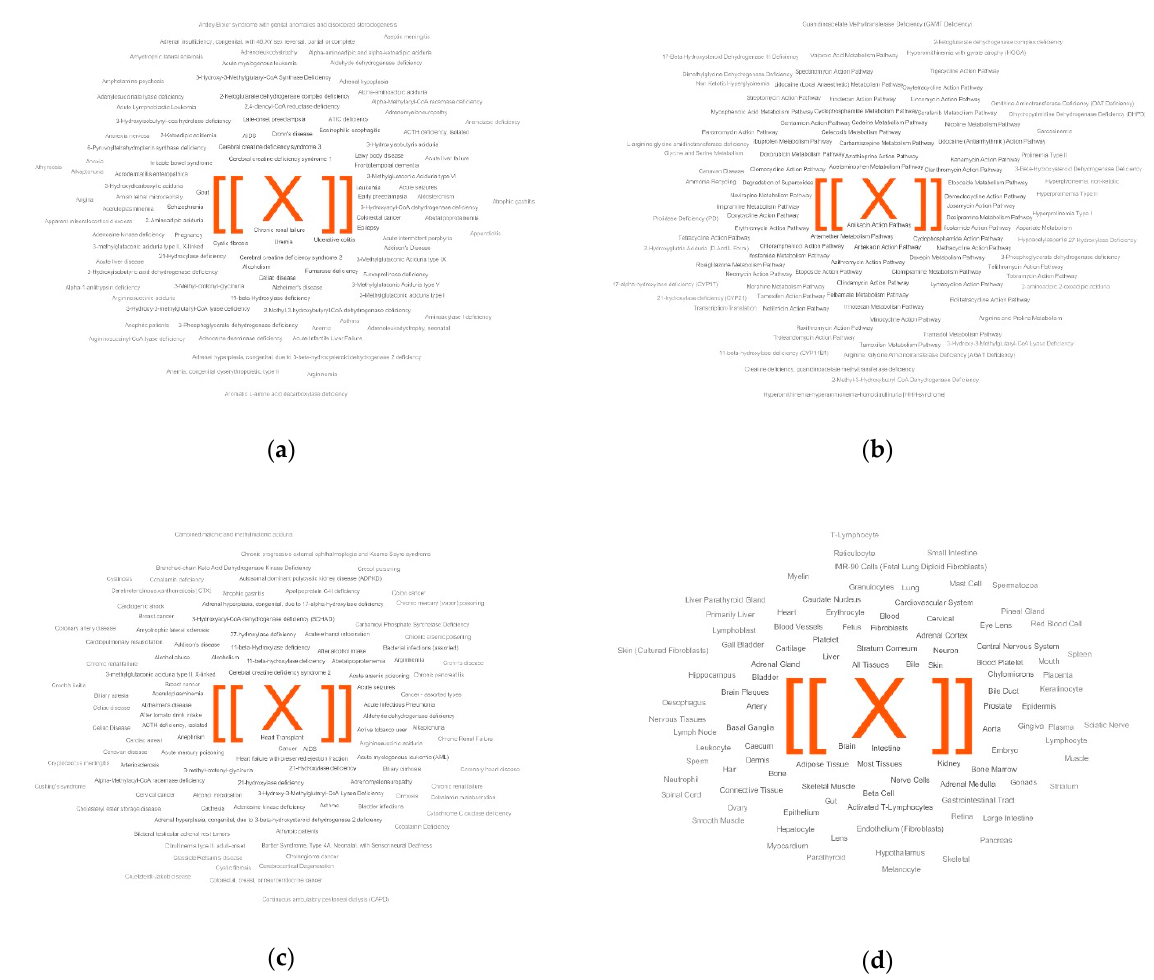
Figure 5. The laboratory-developed test (LDT) outputs for a ‘healthy’ individual. The LDT outputs for the overrepresentation pattern in disease-associated metabolite sets ( a ), pathway-associated metabolite sets ( b ), metabolite sets associated with abnormal concentrations ( c ), and location-based metabolite sets ( d ). No overrepresented metabolite sets were detected, thus confirming that the individual does not have any deviation in the metabolite composition of their blood. [[X]] is a marker corresponding to a representation score of 50.